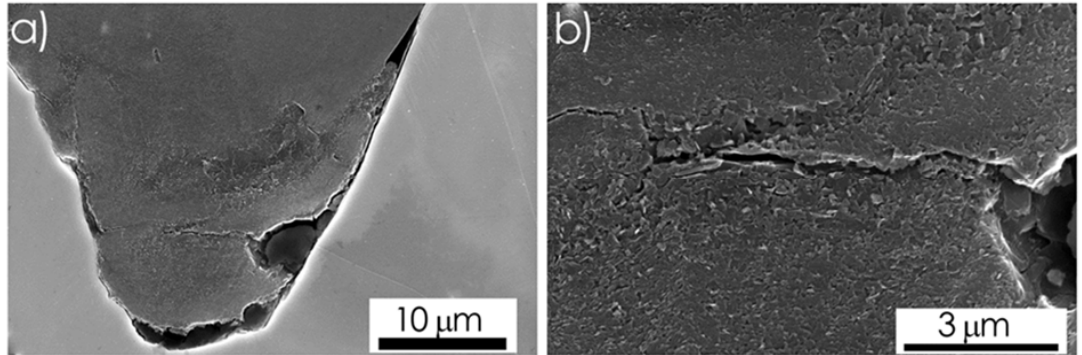
Figure 10. Intermediate stage of destruction in graphite spheroid in SNi9 specimen, at a distance of 1 mm from the main fracture surface, SEM: ( a ) Micro ‐ cavities at G ‐ M interface in spheroid elongated in stress direction, ( b ) local crack in the area of the shifted graphene plates.